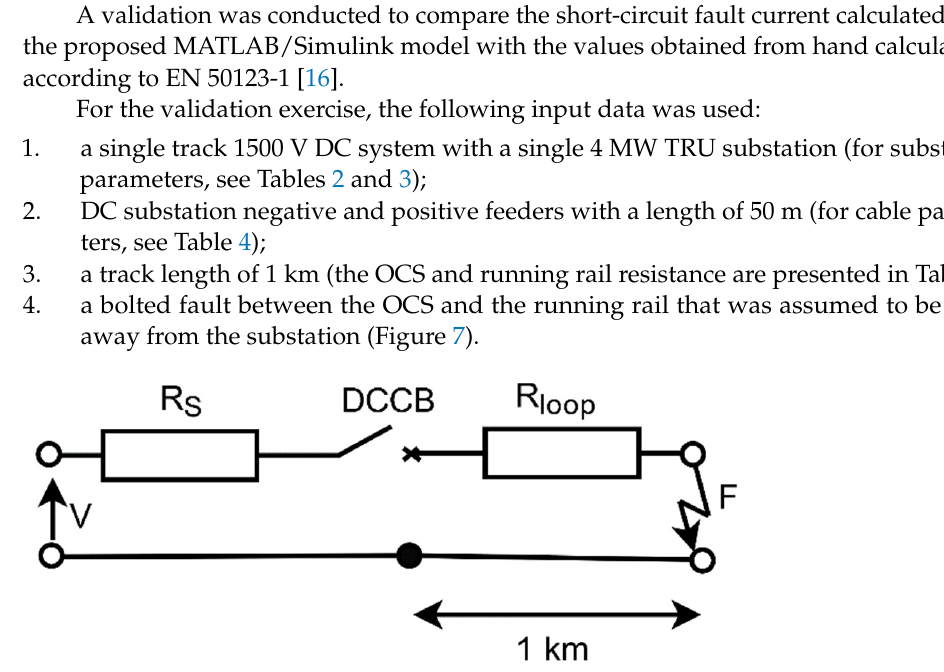
Figure 7. Equivalent circuit of the test model.